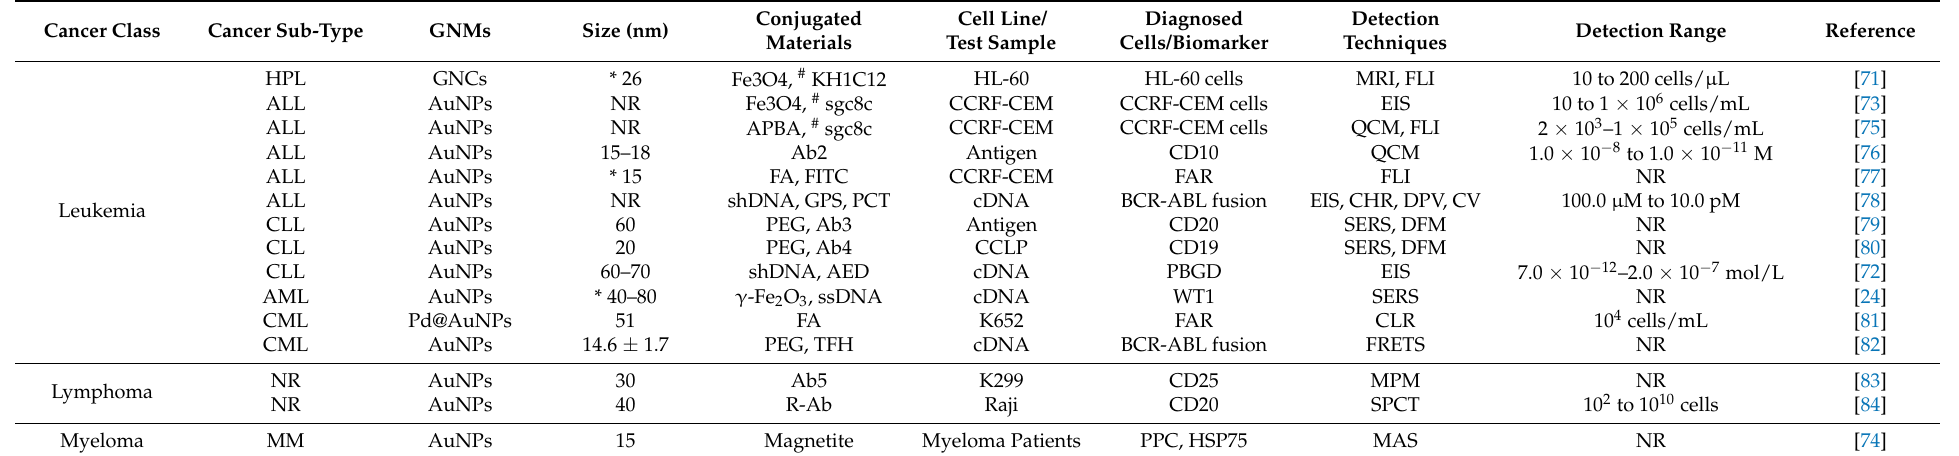
Table 1. Using gold nanomaterials in the diagnosis of hematological